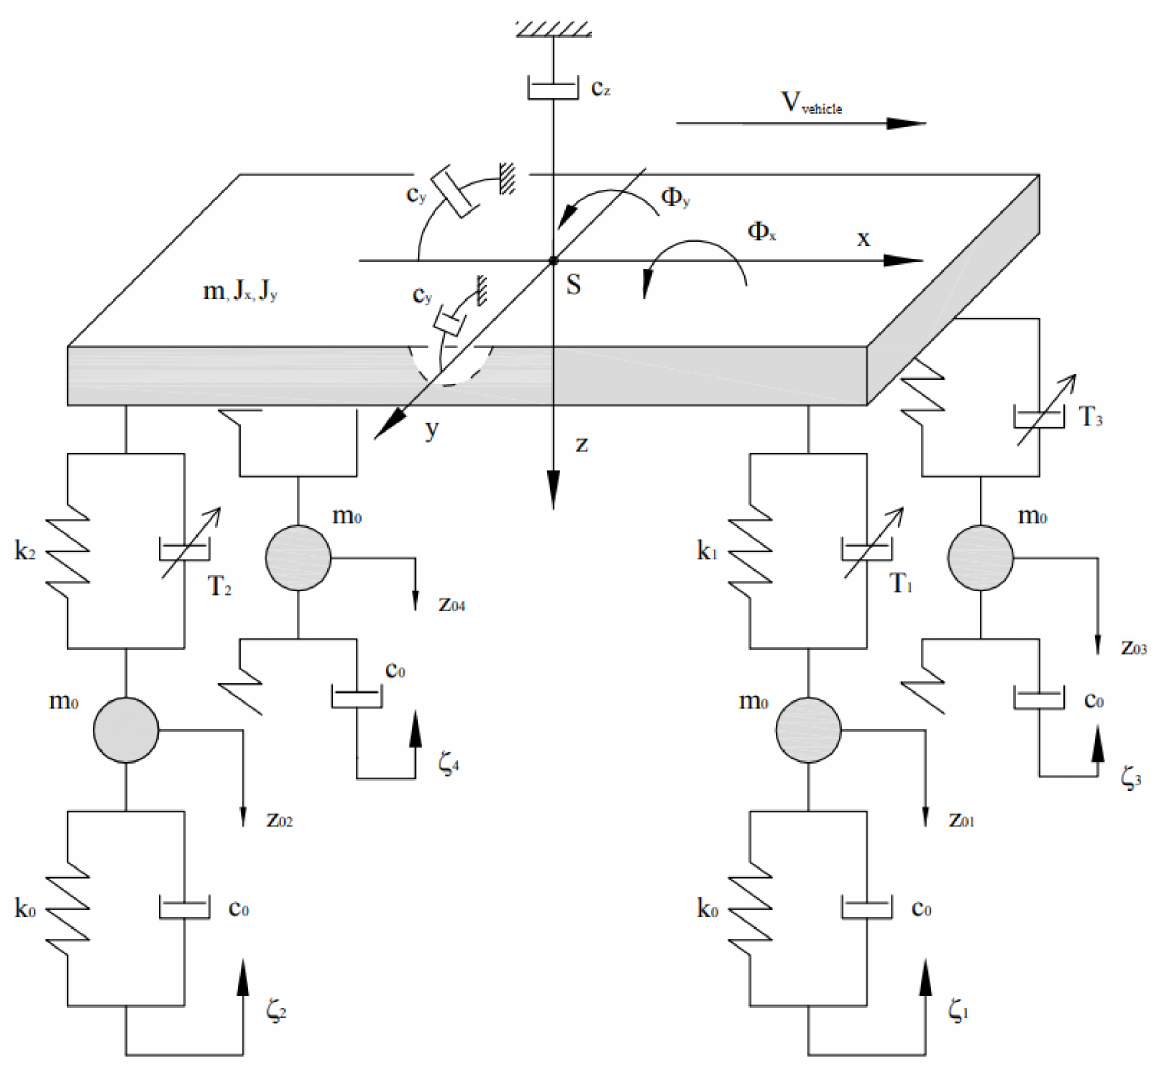
Figure 8. Scheme of the mechanical system adopted as a vehicle model—sky hook; Z—displacement of the bodywork in the Z direction; Φ x —rotation about the X axis; Φ y —rotation about the Y axis; c z —damping coefficient relative to the sky in the Z direction; c x —angular damping coefficient relative to the sky in about the X axis; c y —angular damping coefficient relative to the sky in about the Y axis; T 1 , T 2 , T 3 , T 4 —friction forces in suspension; k 1 , k 2 , k 3 , k 4 —spring coefficients in suspension; m 0 —mass of wheel; z 01 , z 02 , z 03 , z 04 —displacement of the wheels in the Z direction; k 0 —spring coefficients in wheel; c 0 —damping coefficients in wheel; ξ 1 , ξ 2 , ξ 3 , ξ 4 kinematic excitations; Vvehicle—vehicle